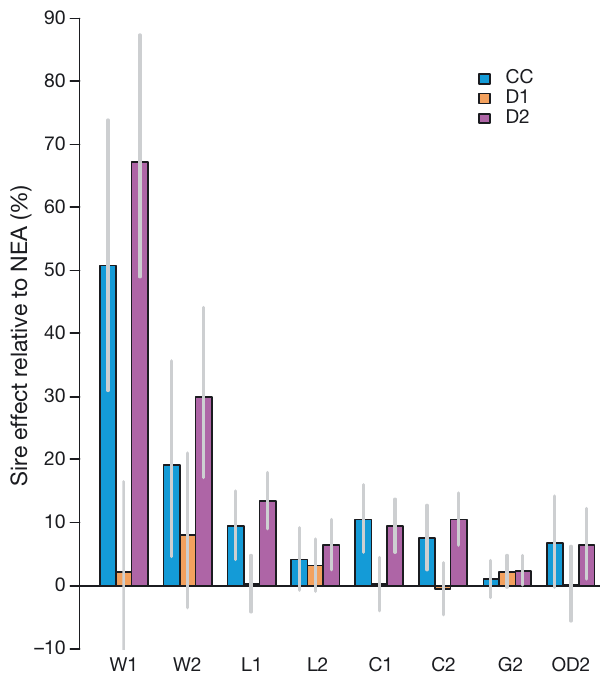
Fig. 4. Modeled effect of cod sire group on different meas- ures taken at end of Phases I and II of Expt A. The sire effects for broodstock groups D1 and D2 and wild-caught coastal cod (CC) are given as a percentage relative to the wild Northeast Arctic (NEA) group. Error bars show 95% confidence limits. Parameter codes as in Fig. 3. See Table 2 for further description of modeling